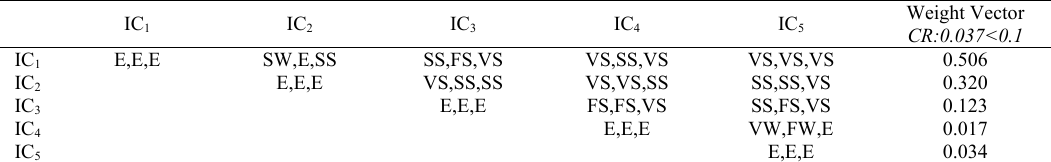
Table 5. Evaluations of Experts in Linguistic Variables and Weights of the Internal